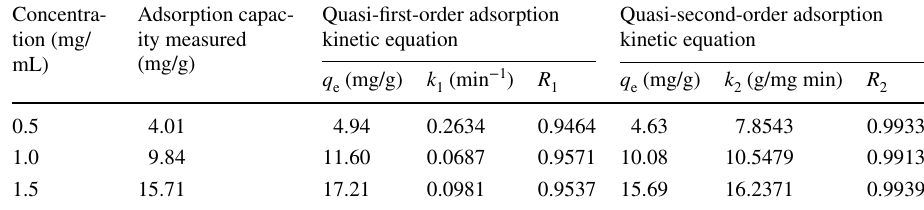
Table 2 Kinetic parameters of